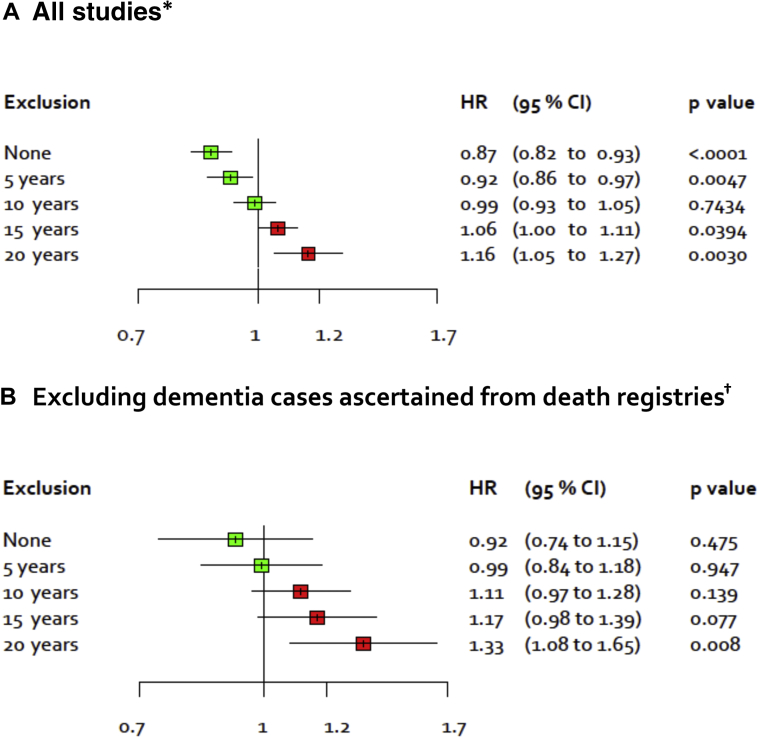
Age-, sex-, and ethnicity-adjusted HR for incident dementia per 5-kg/m2 increase in BMI after progressive exclusion of the follow-up period in all studies (A)∗ and in studies with dementia ascertainment using dementia morbidity data (B)†. ∗39 studies, total N = 1,349,857. †5 studies, total N = 95,851. The figure shows that risk of bias due to preclinical dementia decreases with increasing exclusion of the follow-up period. Abbreviations: BMI, body mass index; CI, confidence interval; HR, hazard ratio.